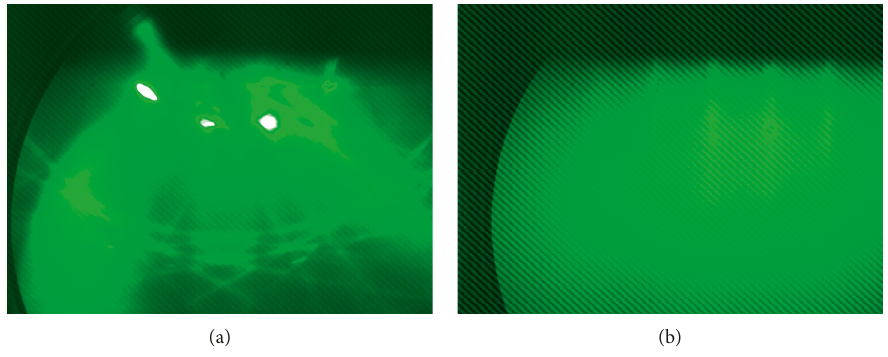
Figure 1: RHEED pattern of (a) c-plane sapphire substrate and (b) grown Ga